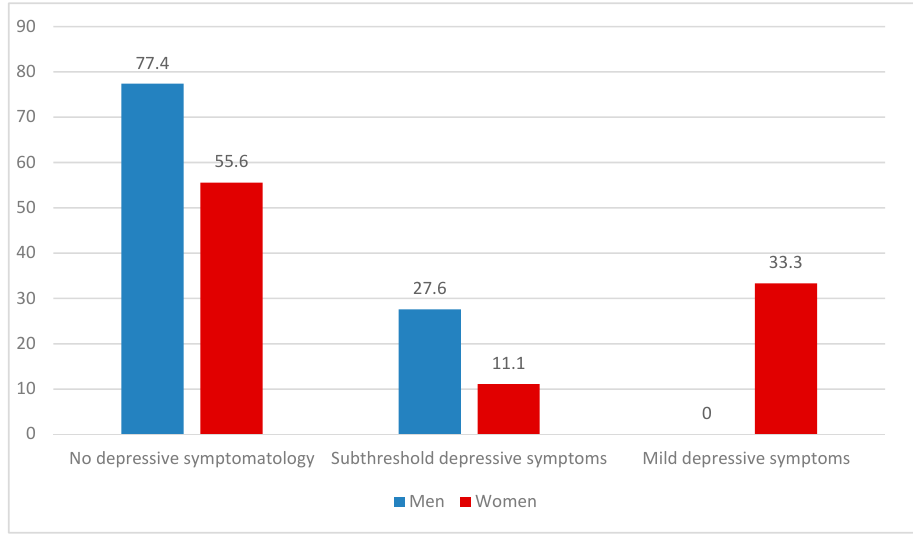
Figure 1. Depressive symptomatology (as measured by PHQ-9) reported by volunteers by gender (%). A statistically significant difference emerged in the comparison between subjects with volunteer experience longer than 10 years reporting higher GHQ-12 median scores (effect size = 0.12) and displaying a worse emotional condition compared to the less experienced volunteers (Table 5). Table 5. Psychopathological and coping strategies data of Civil Protection less experienced volunteers serving during the COVID-19 pandemic compared to more experienced volunteers.